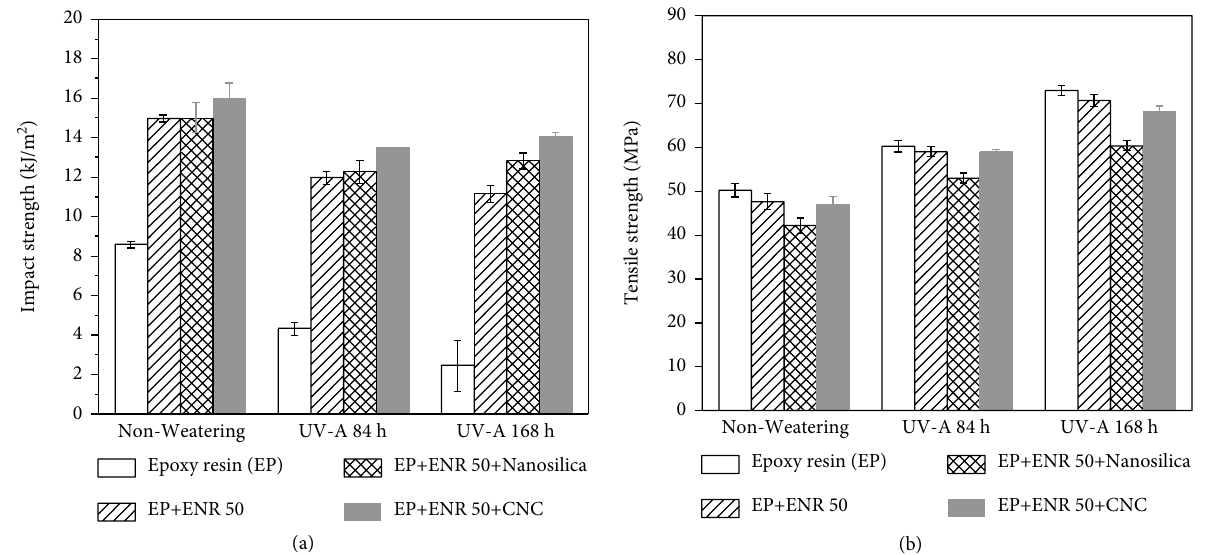
Figure 6: The mechanical properties of before and after accelerated aging of nanocomposites: (a) impact strength, and (b) tensile